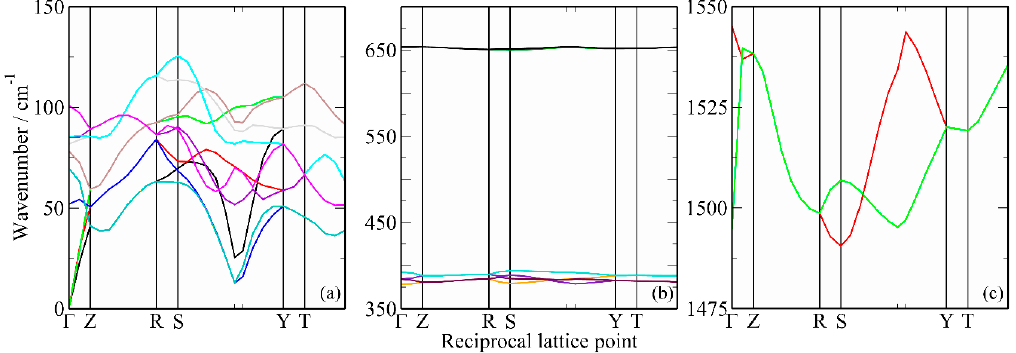
Figure 5. Calculated dispersion curves of solid CS 2 . ( a ) In the lattice mode region, ( b ) ν 2 and ν 1 , and ( c ) ν 3 .